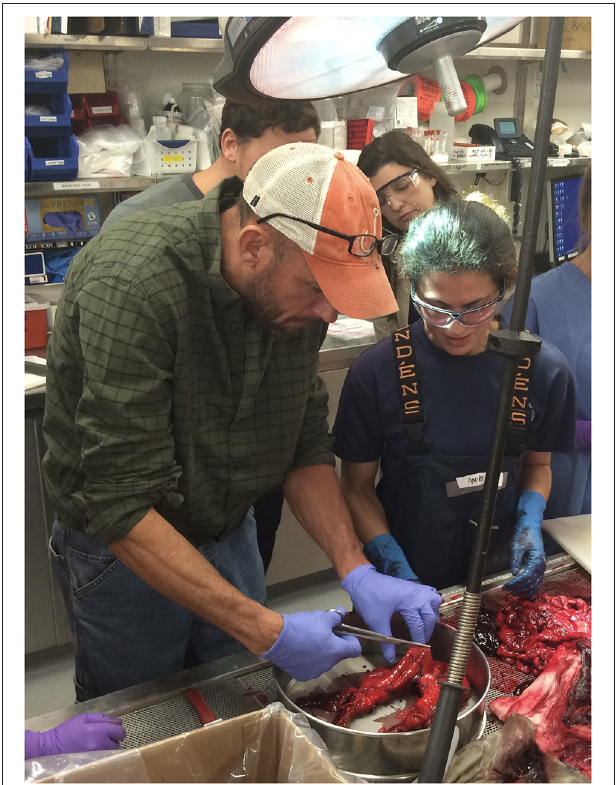
FIGURE 2 | Participants take part in the necropsy of stranded and bycaught seals. Here, a commercial fisherman works on opening the stomach of one of the bycaught gray seals recovered from a